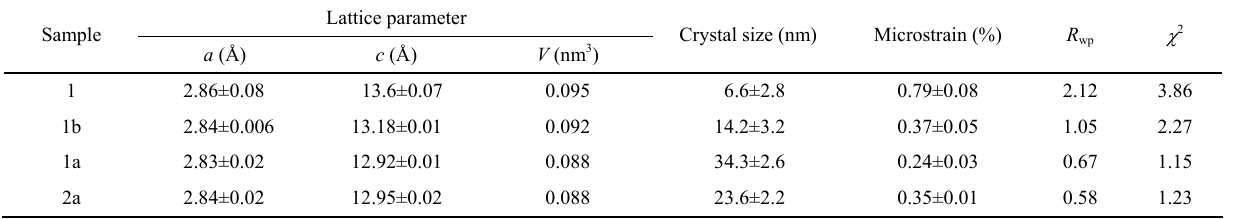
Table 2 Lattice parameters, average crystal size, and microstrain for the investigated samples. R wp and  2 (goodness of fit) are also